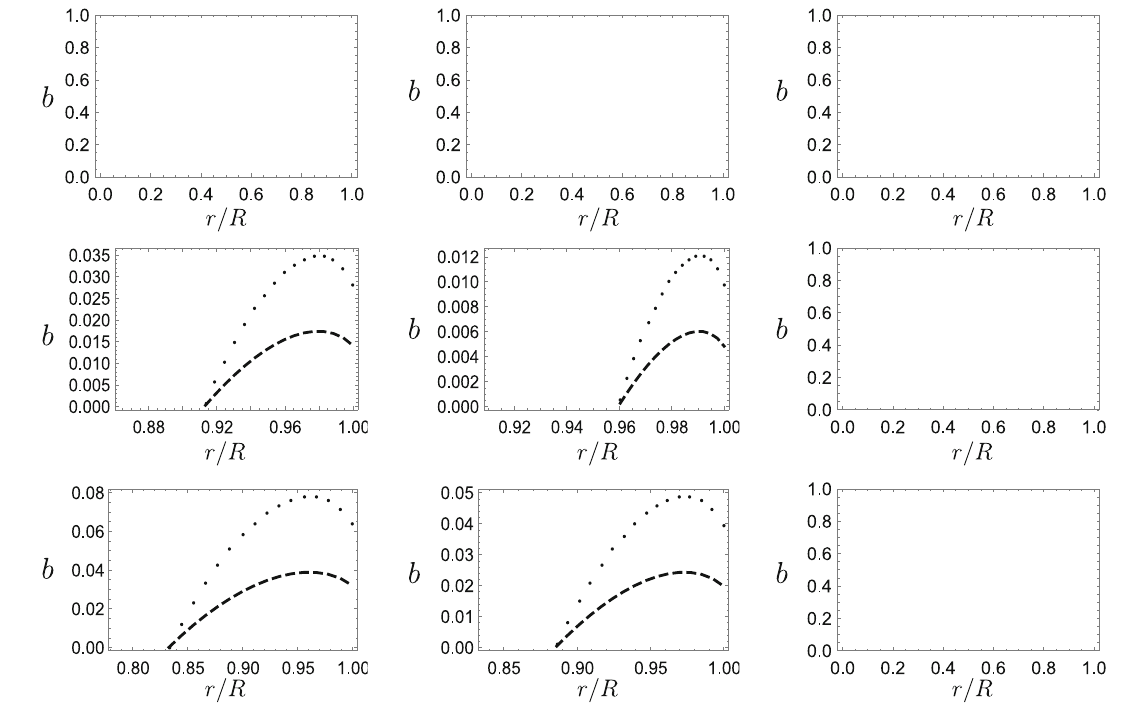
Fig. 16 The local trapping efficiency coefficient b for R / M = 3 . 2 is plotted for several values of j and θ . There is no trapping here for the non-rotating configuration and trapping only for counter-rotating direc- tionsintherotatingcase.Thelocaltrappingfortherotatingcaseisagain shown with the dashed lines and the points above them show results for